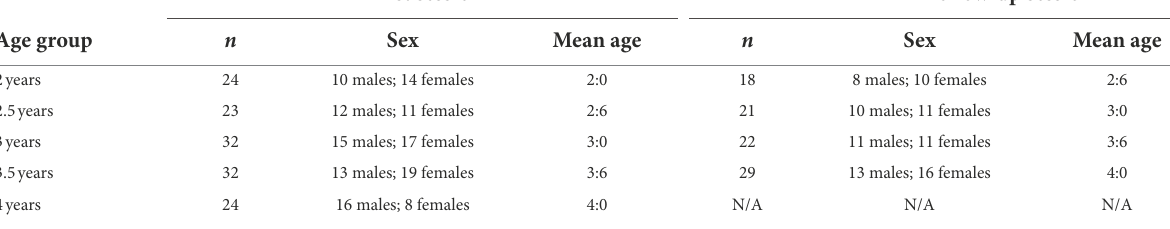
TABLE 2 Sample descriptive statistics for the first and follow-up session of each age